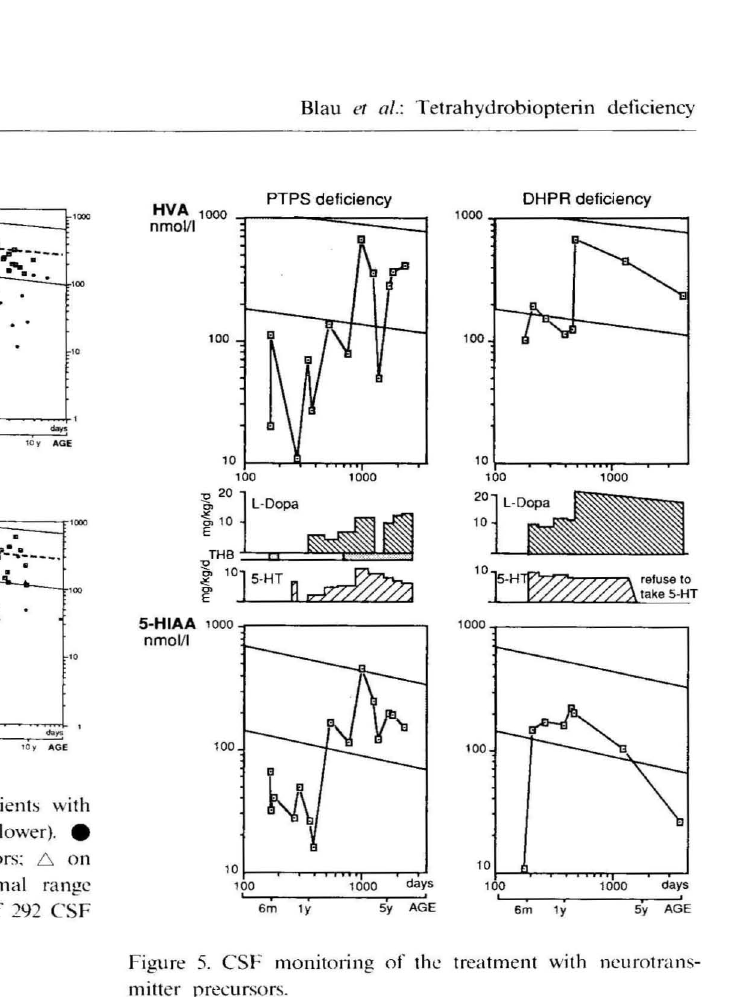
Figure 5. CSt-' monitoring of the treatment with neurotrans mitter